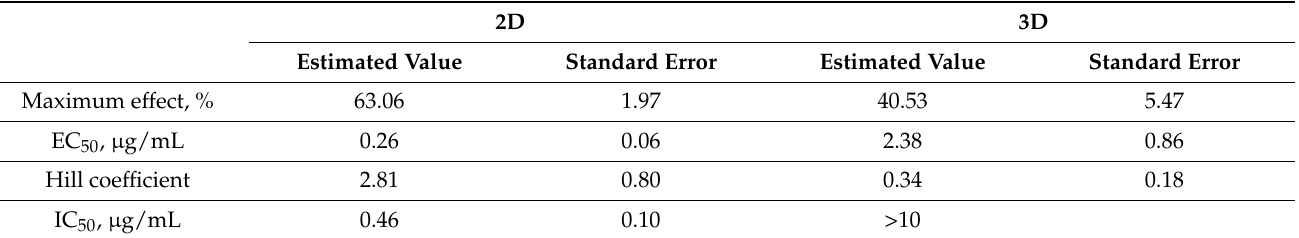
Table A7. The results of fitting the dose–response model to the measurements of cell viability. Estimated values of the dose–response model parameters for AMS-6-Dox in 2D and